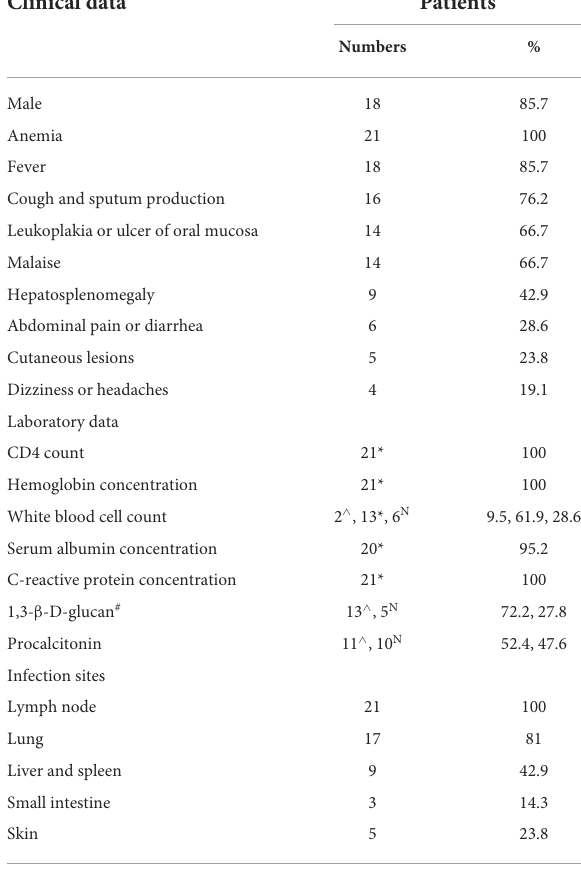
TABLE 1 Demographic information, clinical manifestations, laboratory data and infection sites in HIV patients infected with Talaromyces marneffei with lymphadenopathy ( n =